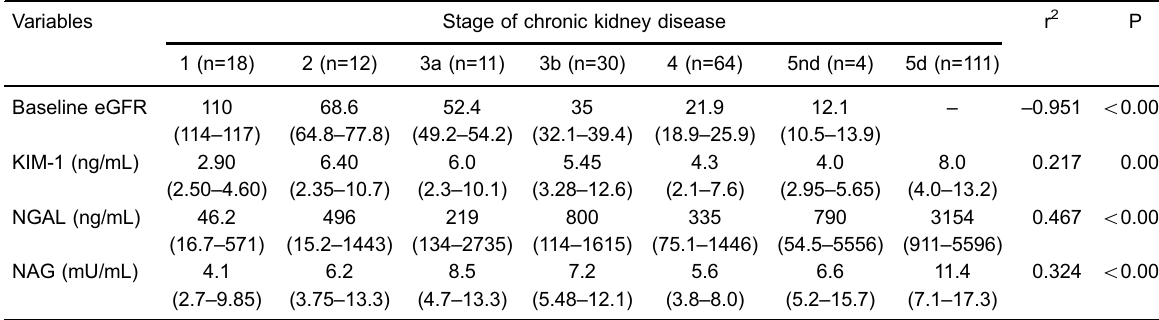
Table 2. Urinary values of biomarkers according to the stage of chronic kidney disease. Variables